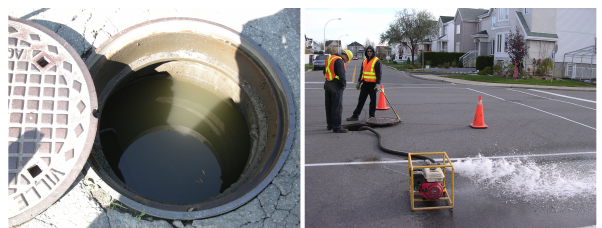
Figure 1. Flooded air-vacuum valve vault.